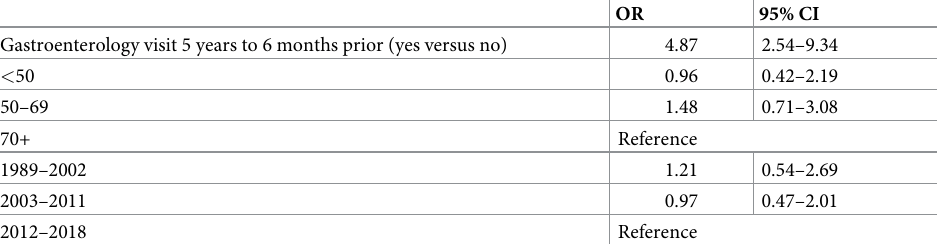
Table 5. Multivariable logistic regression analysis assessing use of colonoscopy in the 5 years to 6 months prior to